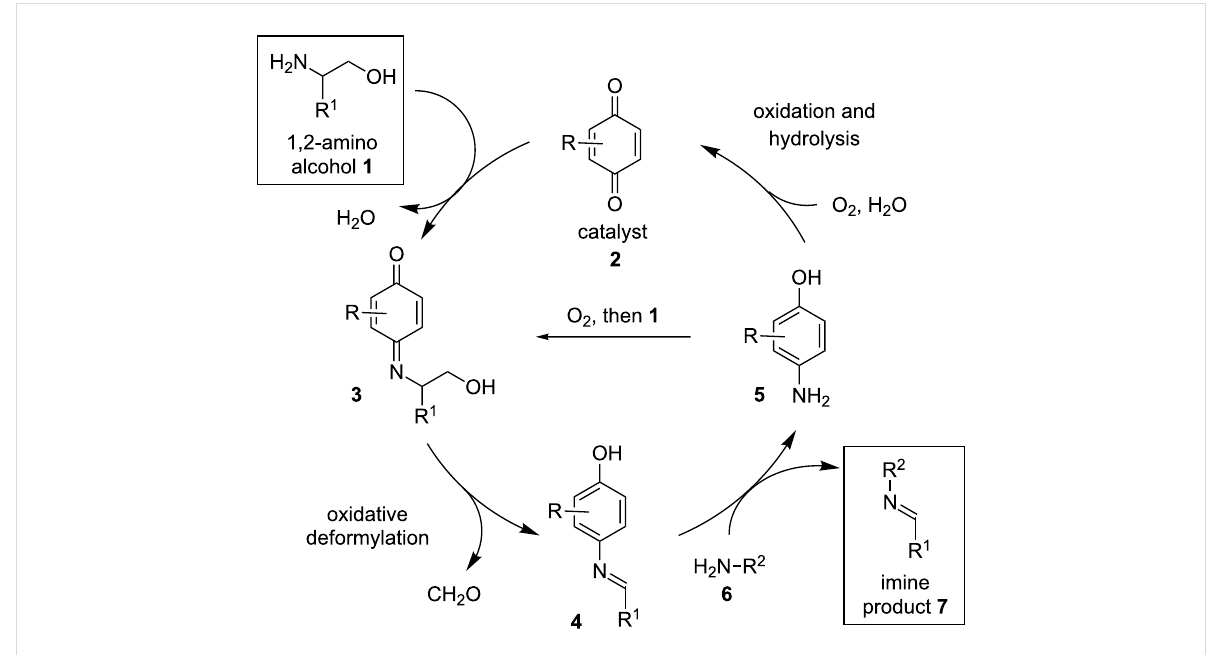
Scheme 2: Proposed catalytic cycle for quinone-catalyzed